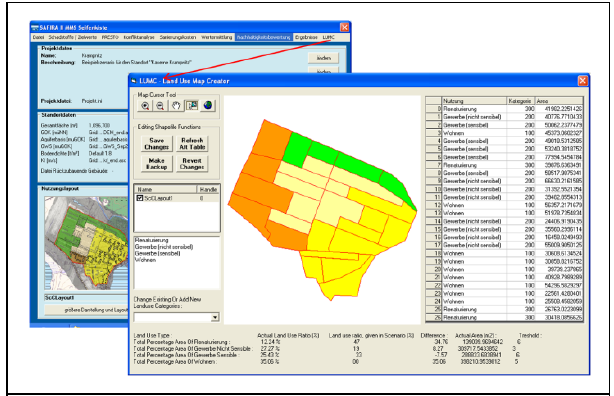
Figure 2 : Final integration of MapWinGIS application into MMT